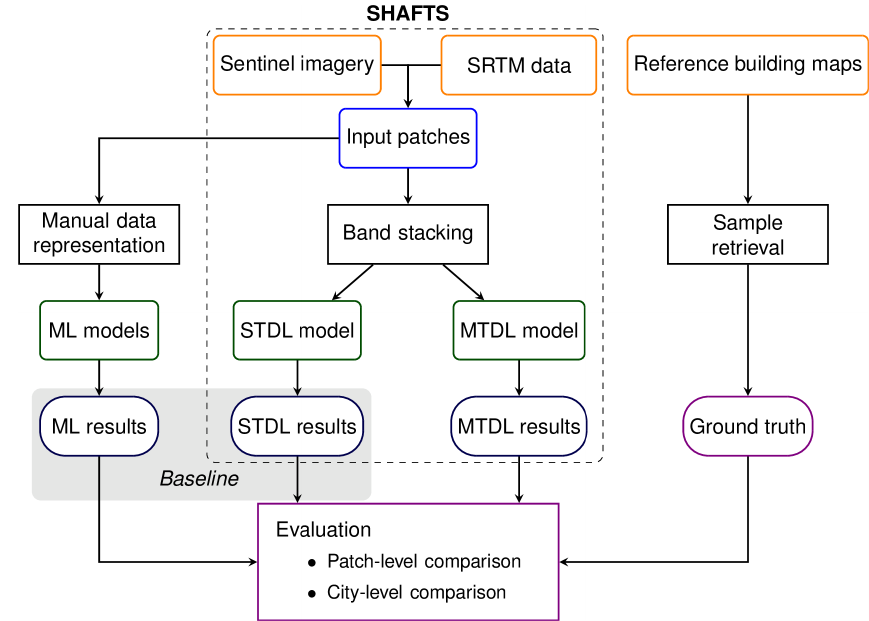
Figure 1. Overview of workflows to estimate building height and building footprint using ML and DL